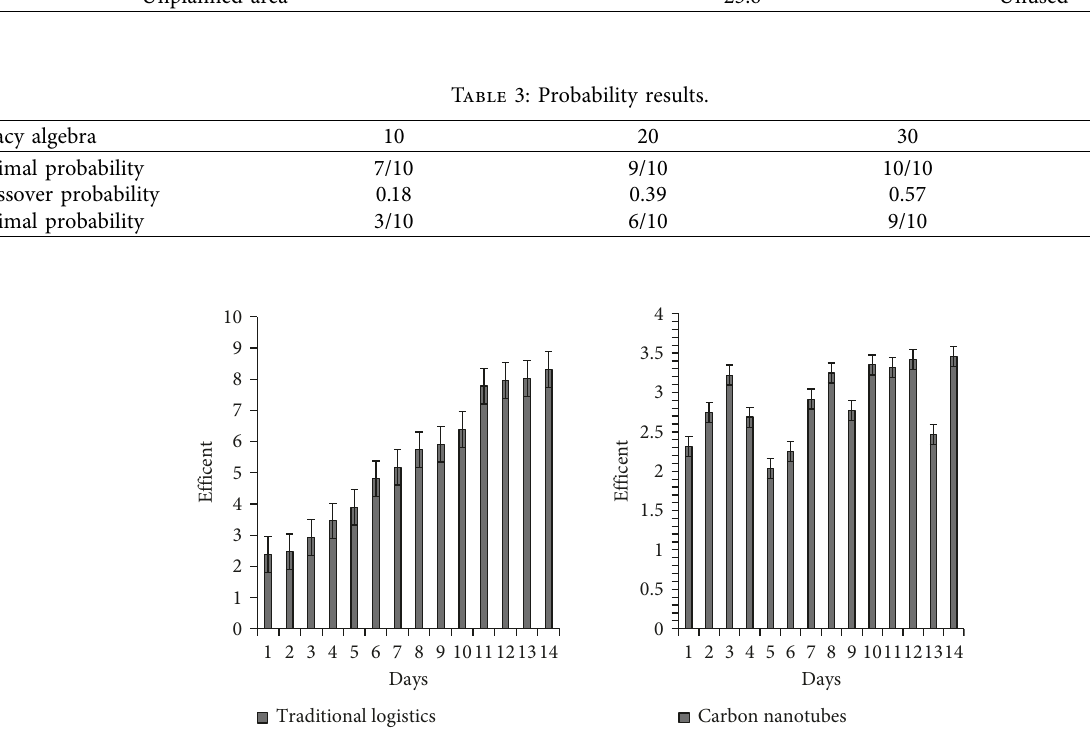
Figure 8: Efficiency comparison before and after